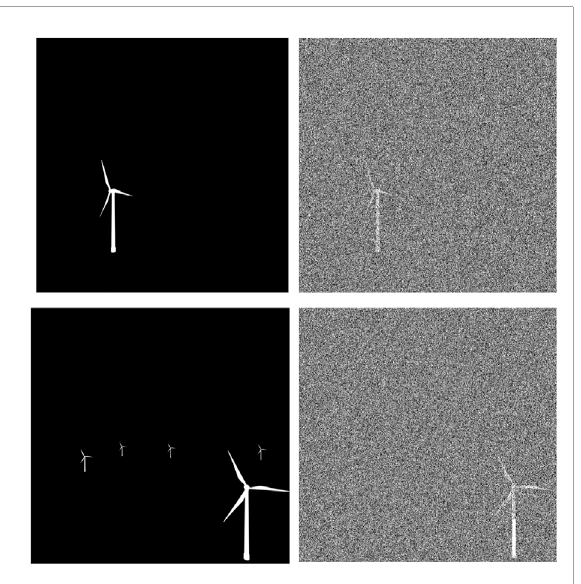
FIGURE 3 Examples of original masks and soft masks. The left column is original masks, and the right column is soft masks.